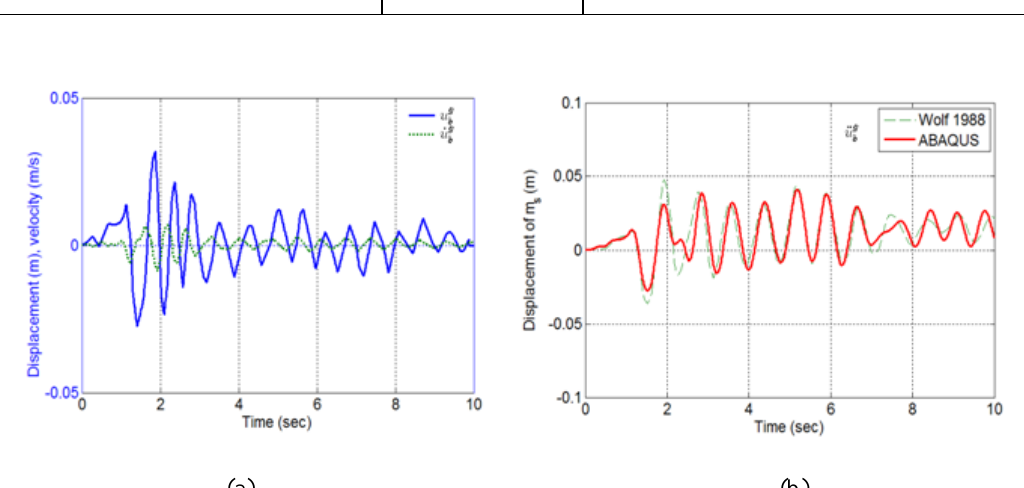
Figure 5. (a) Ground motion displacement and velocity, (b) comparison of displacement history of mass 𝑚